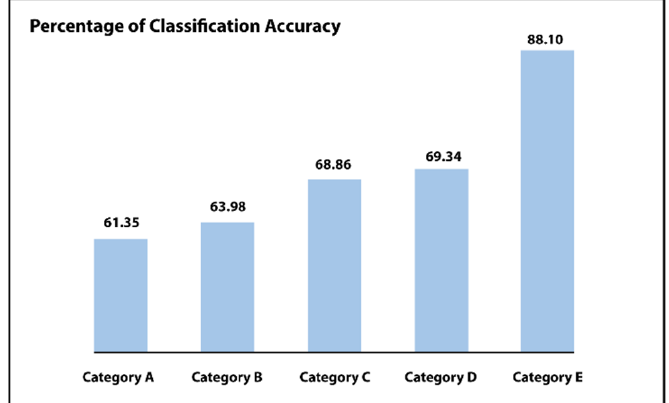
Figure 9. First phase results of Inception-ResNet comparing different categories.